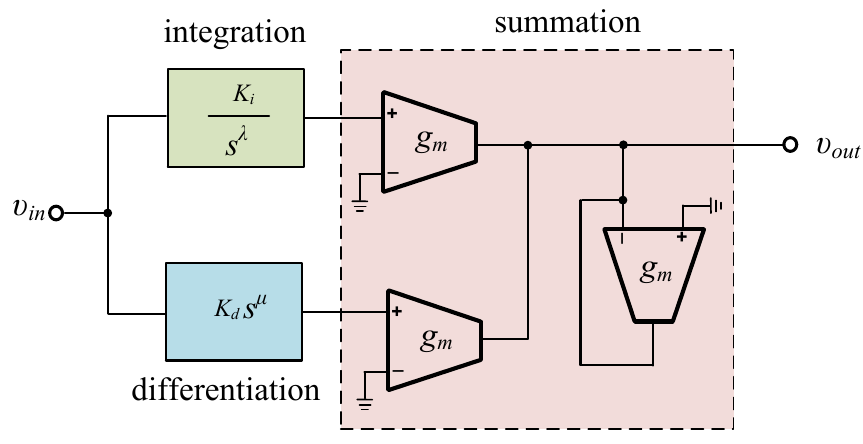
Figure 2. Typical functional block diagram for implementing a DC motor controller.